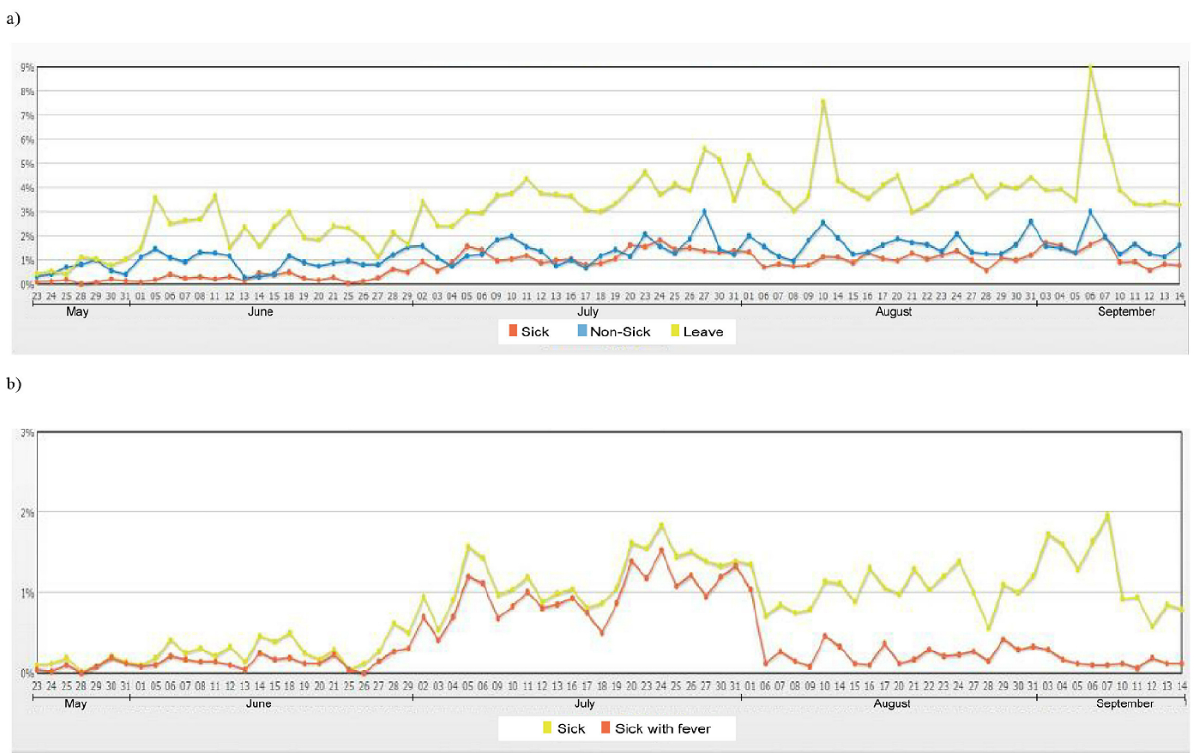
Figure 5. Graphs showing patterns of school absenteeism generated from the system from 24 May to 14 September 2012 (First Semester). a) Pattern of overall absenteeism; b) Pattern of sick leave with and without